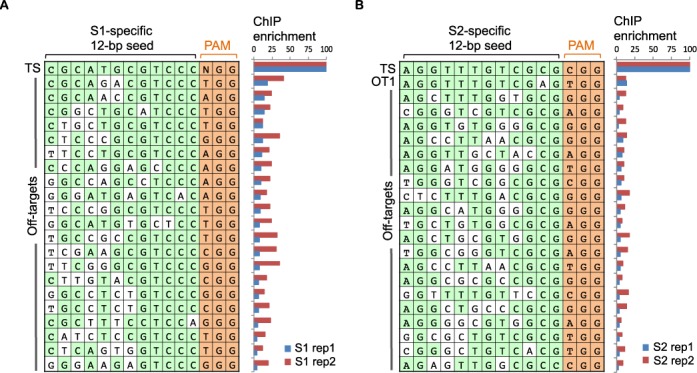
Genomic sequences bound by Cas9:gRNA. Comprehensive list of sequences in ChIP-bound regions that contained a match to the 12-bp seed sequence of the target site when allowing up to four mismatches to S1 (A) and S2 (B) target sites. Nucleotides identical to the target site are highlighted in green. The PAM (NGG) is depicted in orange. Bar graphs on the right display percent ChIP-seq enrichment relative to the target site (TS, top bar). Enrichments are shown for two independent experiments, rep1 and rep 2. Rep1 was obtained after exposure to lower amounts of dCas9 expressing plasmid (1 μg) for 24 h, while rep2 was transfected for 48 h with 7.5 μg dCas9 expressing plasmid.